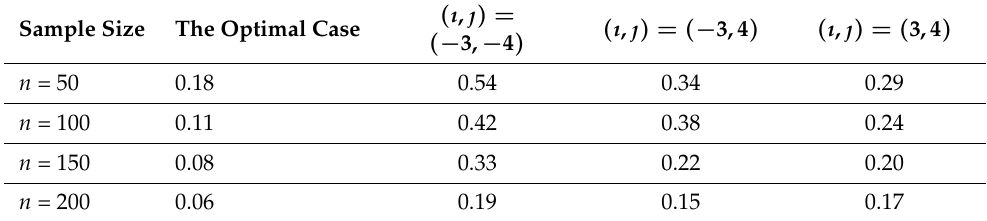
Table 1. MAE of the conditional density estimation with respect to the number neighborhood. Sample